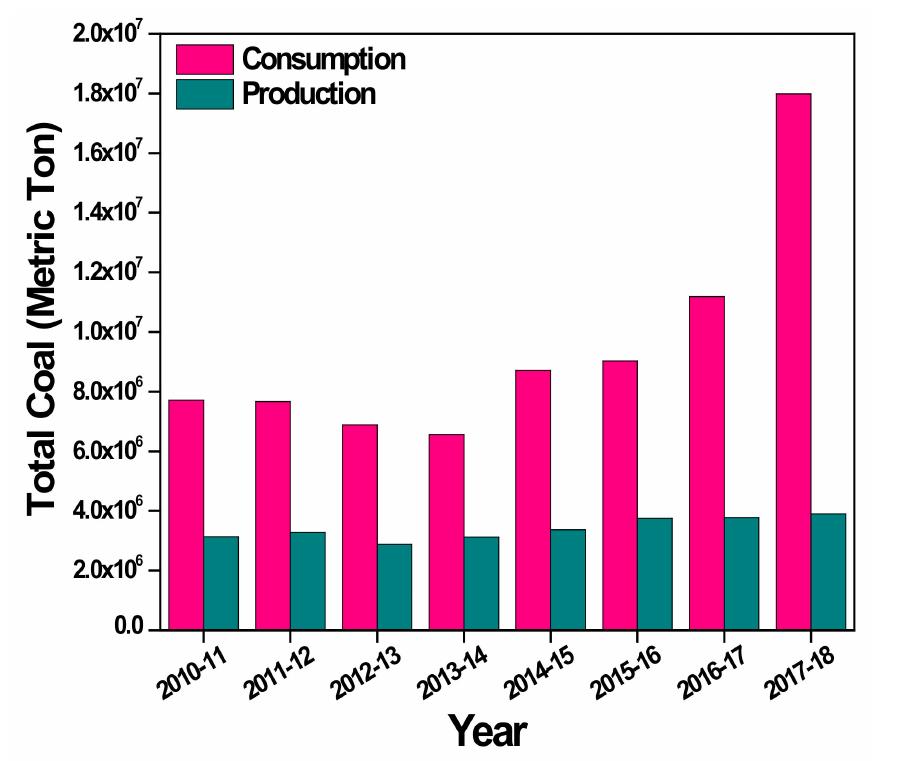
Figure 6. Total production and consumption of coal in Pakistan